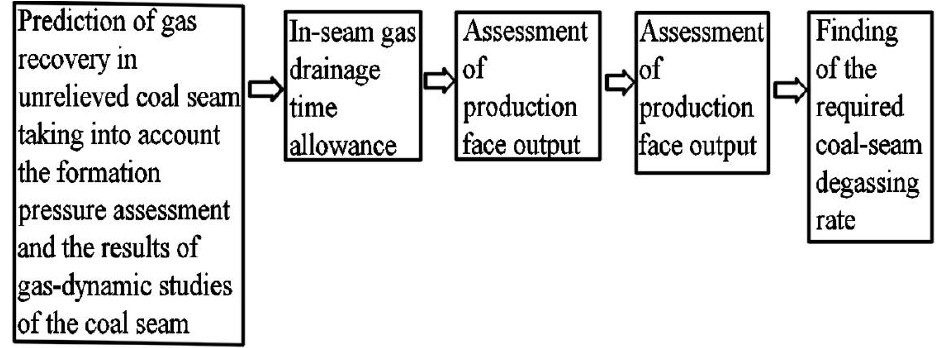
Figure 5. Methodological approach to defining the required effectiveness of in-seam gas drainage (Phase 1).